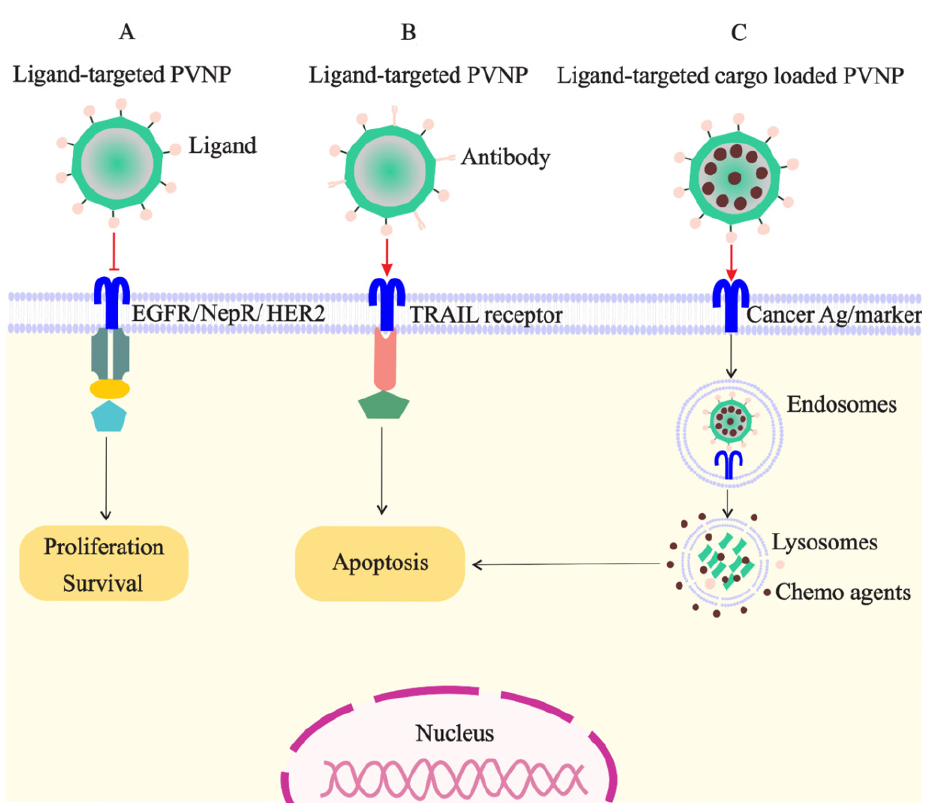
Figure 2. Targeted PVNP/VLP for treatment of breast cancer cells: ( A ). the ligands of receptors over- expressed on cancer cells (e.g., EGFR, NepR, and HER2) can link to PVNPs and inhibit cell survival and proliferation; ( B ). the ligand of TRAIL receptor overexpressed on cancer cells can link to PVNPs to induce apoptosis; ( C ). anticancer agents can load in targeted PVNPs for the internalization and delivery in the cancer cell, which subsequently induces cell death.